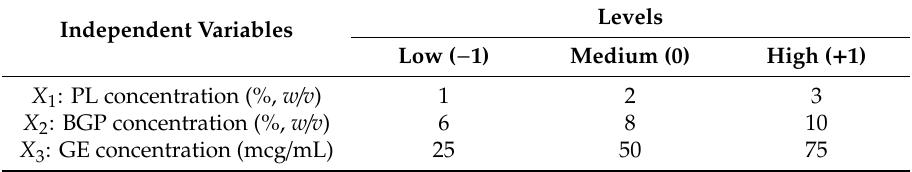
Table 1. Independent variables and their levels in the Box–Behnken design